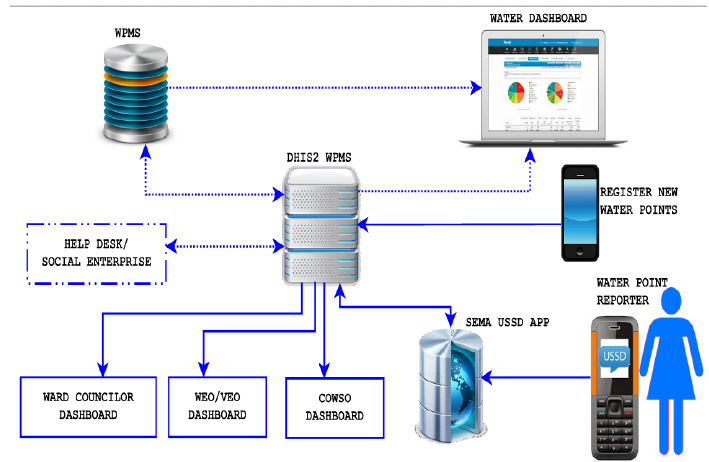
Figure 2. Architecture of the SEMA Water Services Information Infrastructure.